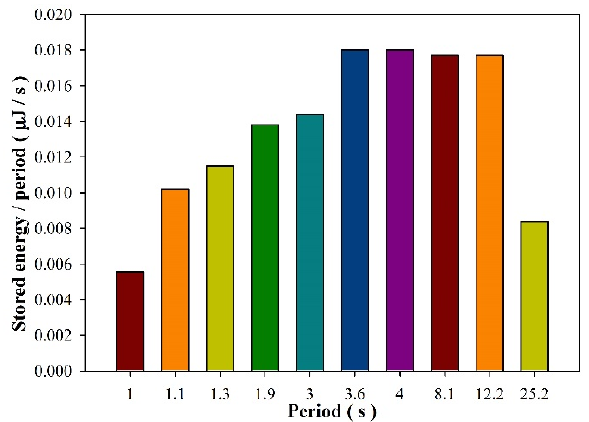
Figure 10. Relationships between the stored energy per period and various periods under the commercial PZT pyroelectric cell